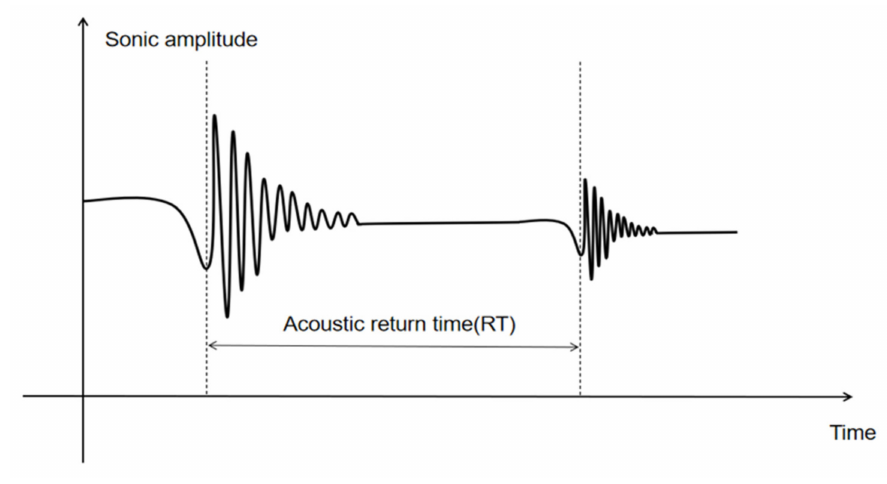
Figure 6. Ultrasonic caliper measurement echo.